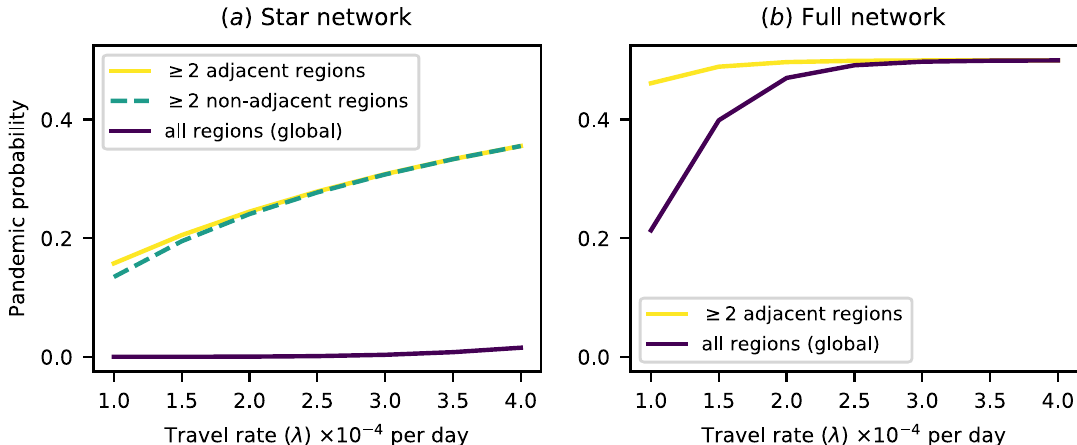
Figure 3. Plots of pandemic probability against between-region travel rate for a range of pandemic definitions. The difference in probability for different pandemic definitions changes as travel rates increase. ( a ) Plot of pandemic probability for a star network. ( b ) Plot of pandemic probability for a full network. For a fully connected network all regions are adjacent, so no line is shown for the interregional definition, which requires non-adjacent regions to experience